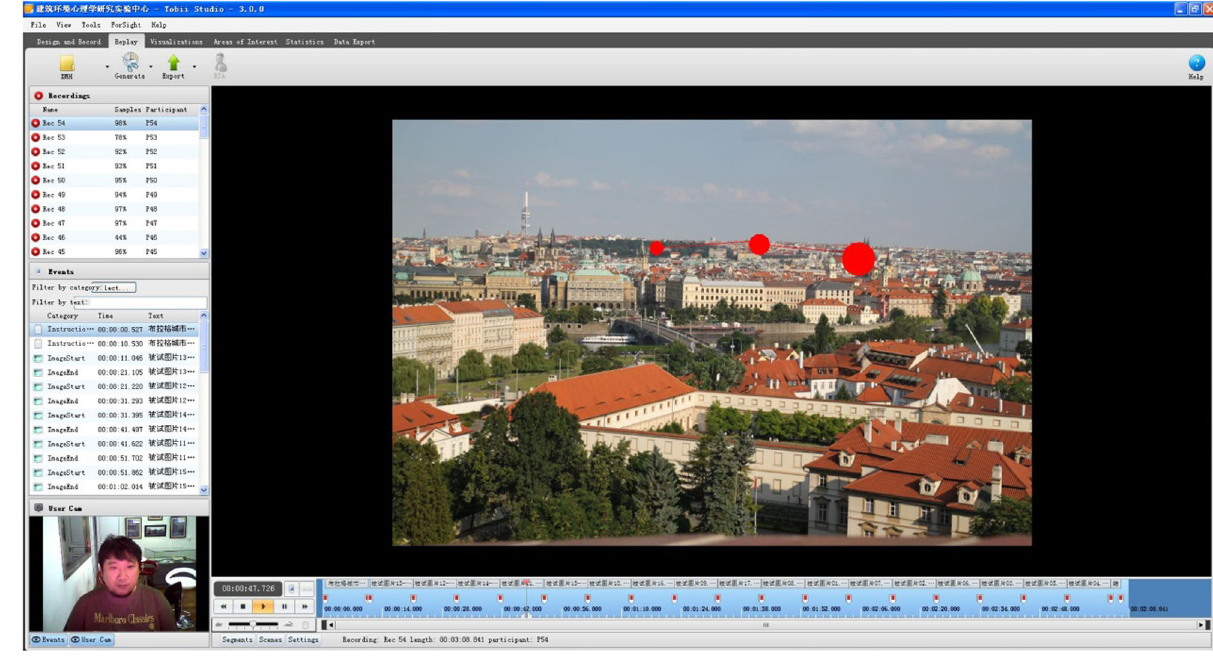
Fig. 5 The 54 test subjects were used in the eye-tracking experiment.